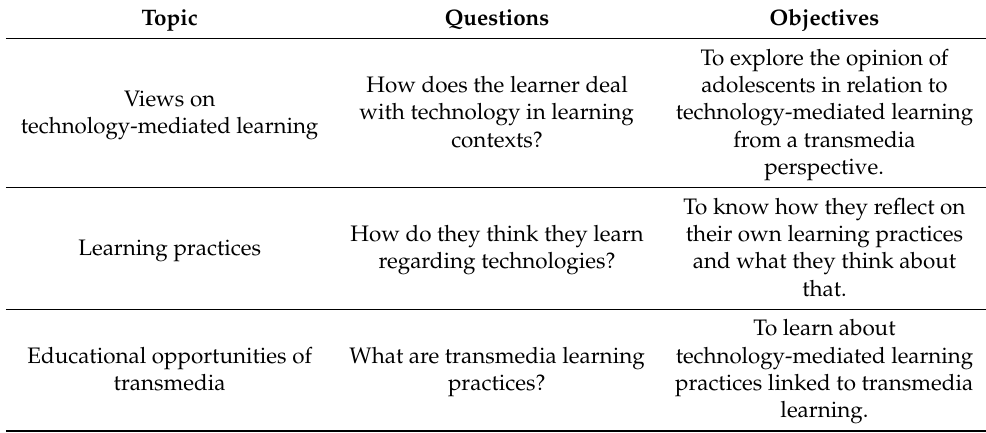
Table 2. Interviews. Research topics, questions, and objectives. Source: Authors’